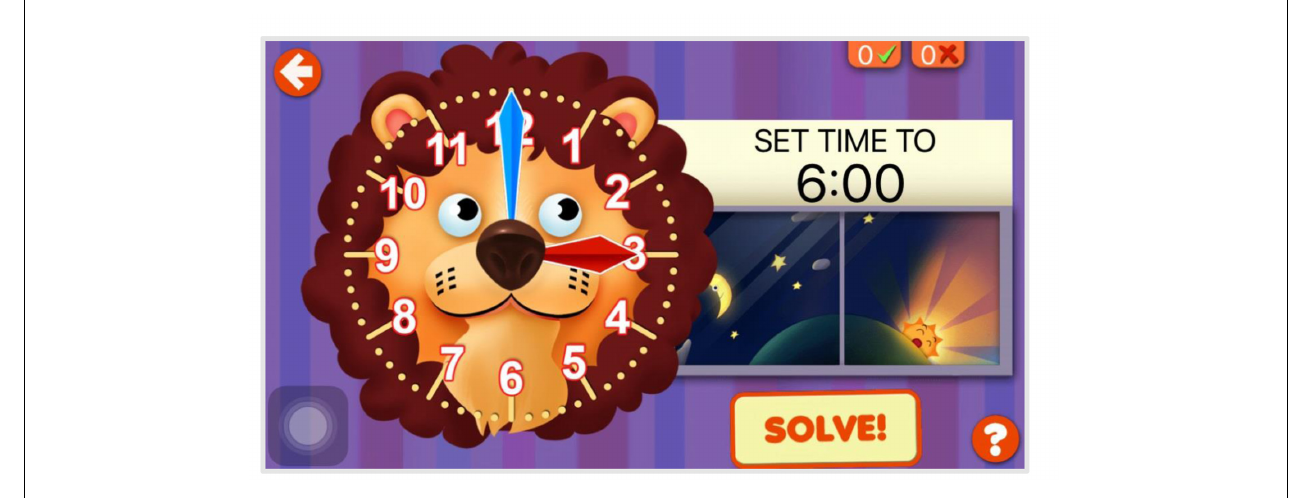
FIGURE 1 | Snapshot taken from Interactive Telling Time “SET the Time” on the iPad.